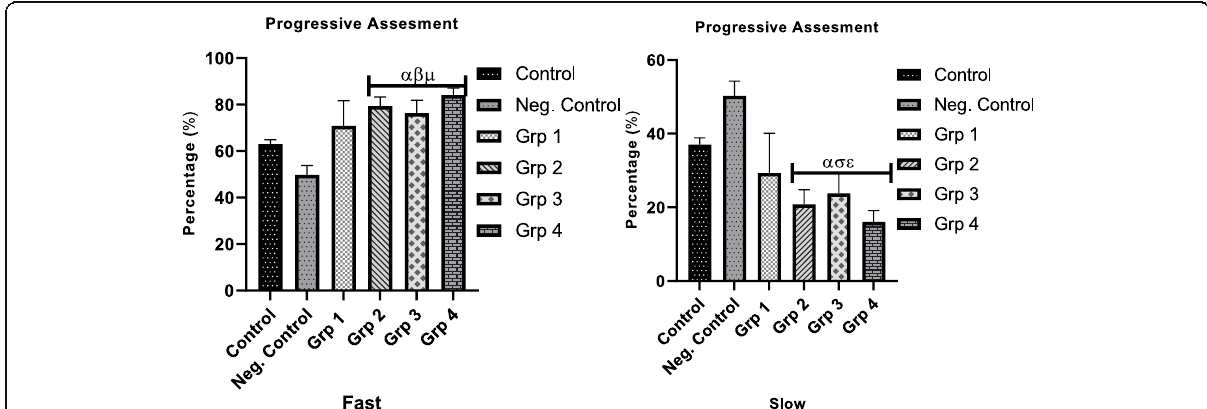
Fig. 2 Graphical representation of sperm progressive assessment. Groups 2, 3 and 4 were statistically significant to Negative control group